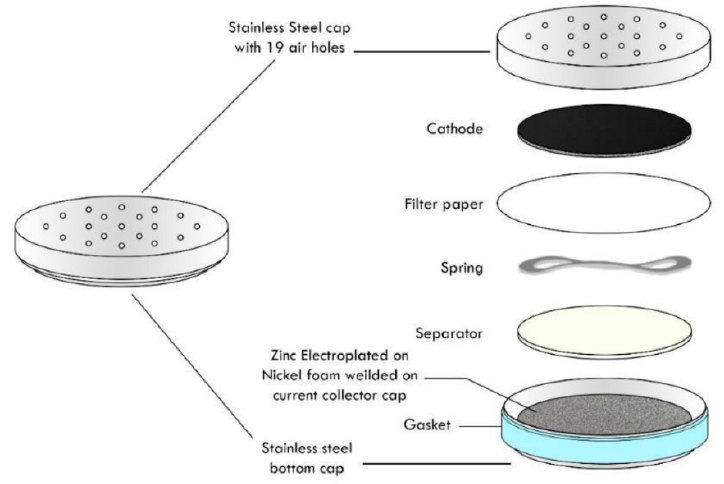
Figure 9. Schematic diagram of the coin cell battery. Figure 8. Schematic diagram of the coin cell